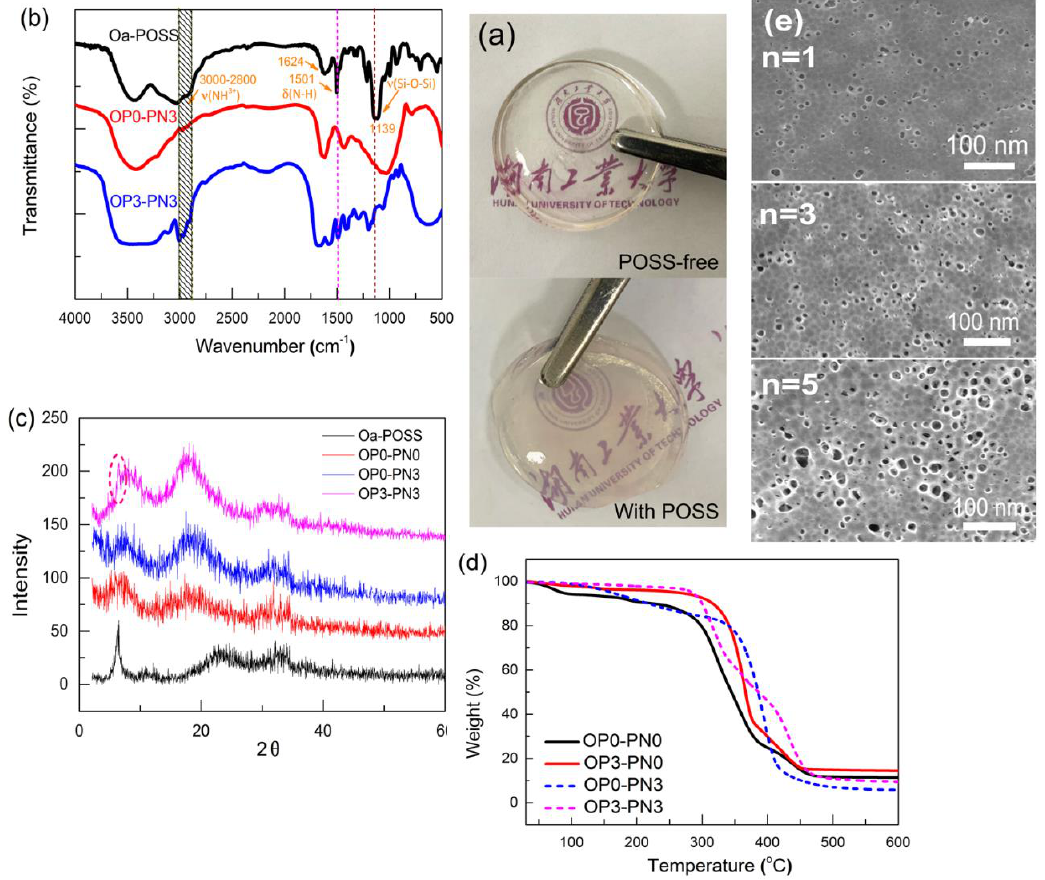
Figure 1. Appearance and structure analysis of OPn-PNm gels: ( a ) photos of interpenetrating polymer network (IPN) gels with and without octa-ammonium polyhedral oligomeric silsesquioxane (Oa-POSS); ( b ) FTIR spectra of Oa-POSS particles and OPn-PNm gels; ( c ) X-ray profiles of Oa-POSS particles and OPn-PNm gels; ( c ) thermogravimetric curves of OPn-PNm gels; ( d ) SEM images of etched OPn-PN3 gels (n = 1, 3, 5).